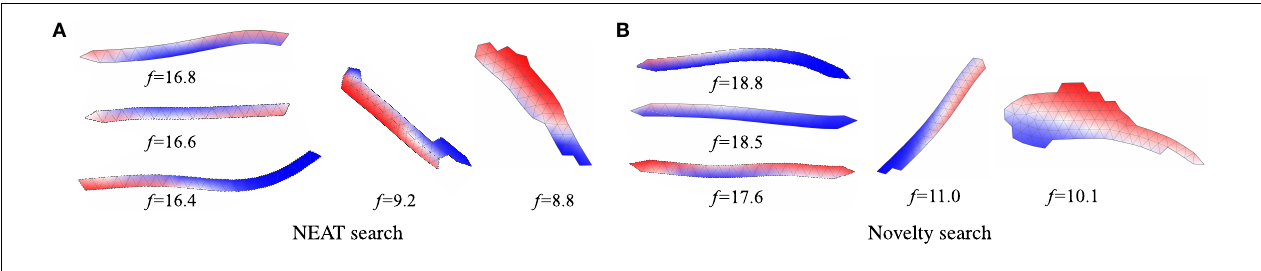
FIGURE 3 | Morphologies of swimming individuals relying on oscillator-driven actuation evolved using NEAT (A) and novelty search (B) and their corresponding fitnesses . Best three individuals and two worst individuals obtained using each search method are shown. Colors indicate evolved phase shifts of muscular contractions, blue corresponds to (cid:0) (cid:25) , white to 0 and red to (cid:25) . Example motion video can be accessed online: http://youtu.be/Gb-H_qy 8 kVQ.